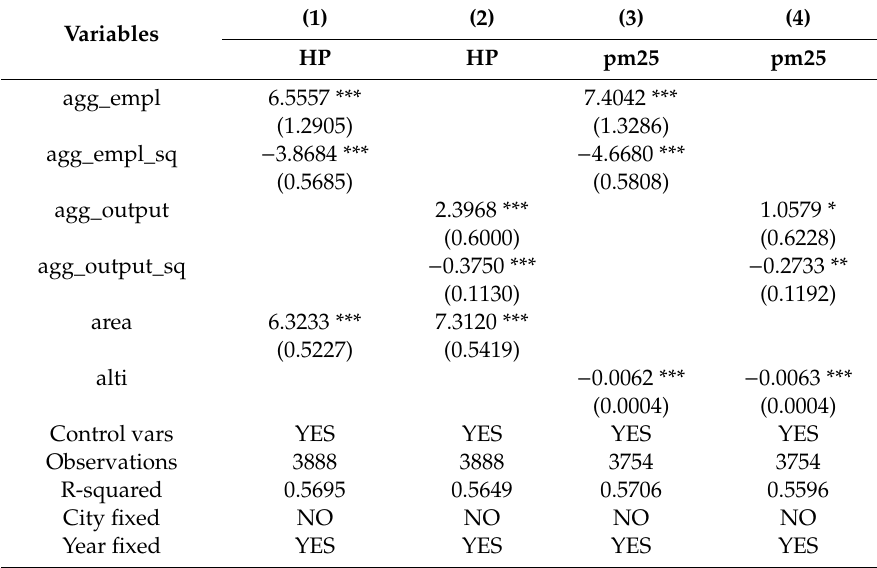
Table A1. Control for area and